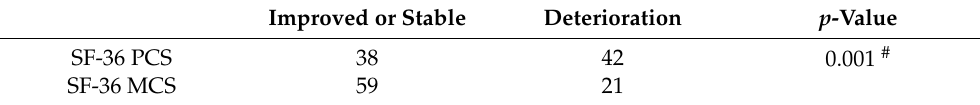
Table 2. Deterioration greater than the MCID between 2 and 5 years postoperatively.